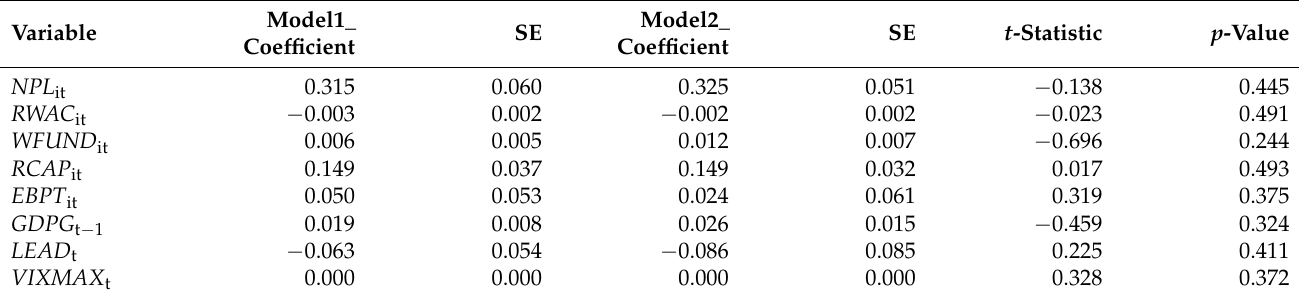
Table A11. Comparison of crisis (3) and crisis (adjusted) (4).